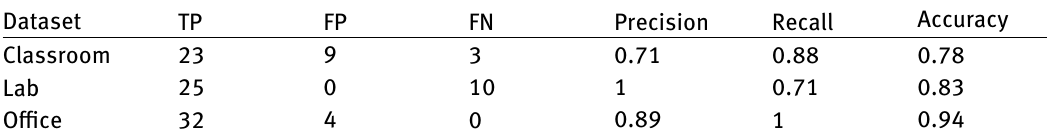
Table 3: Results of Visual Place Recognition. TP, FP and FN are true positives, false positives and false negatives, respectively.